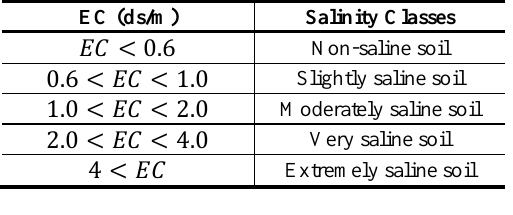
Table 1. Classification of soil based on the electrical conductivity (EC) classification supplied by Duran (1983).